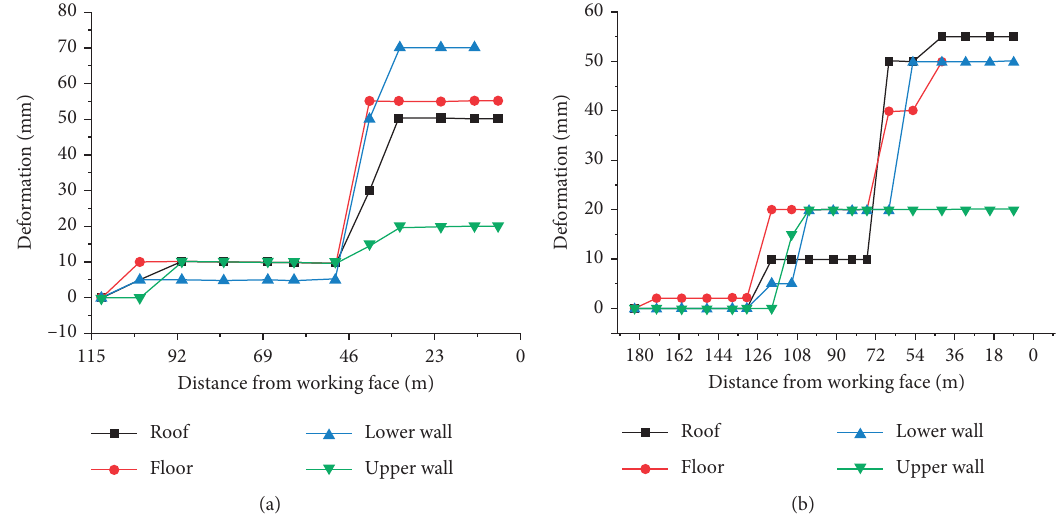
Figure 9: Deformation of the surrounding rocks of the roadway at different distances from the cutting hole. (a) 150m from the cutting hole and (b) 180m from the cutting